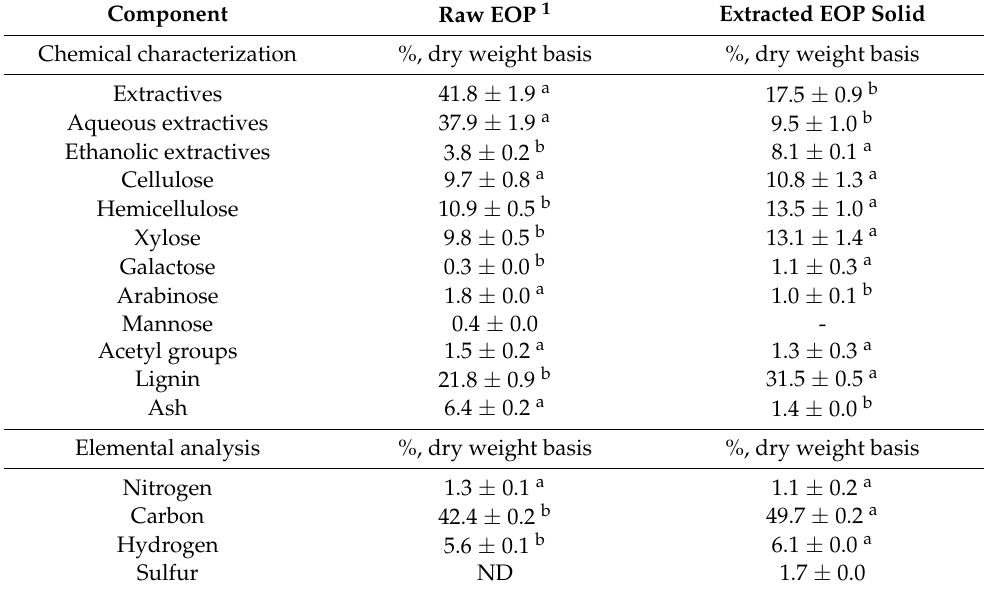
Elemental analysis %, dry weight basis %, dry weight basis Nitrogen 1.3 ± 0.1 a Carbon